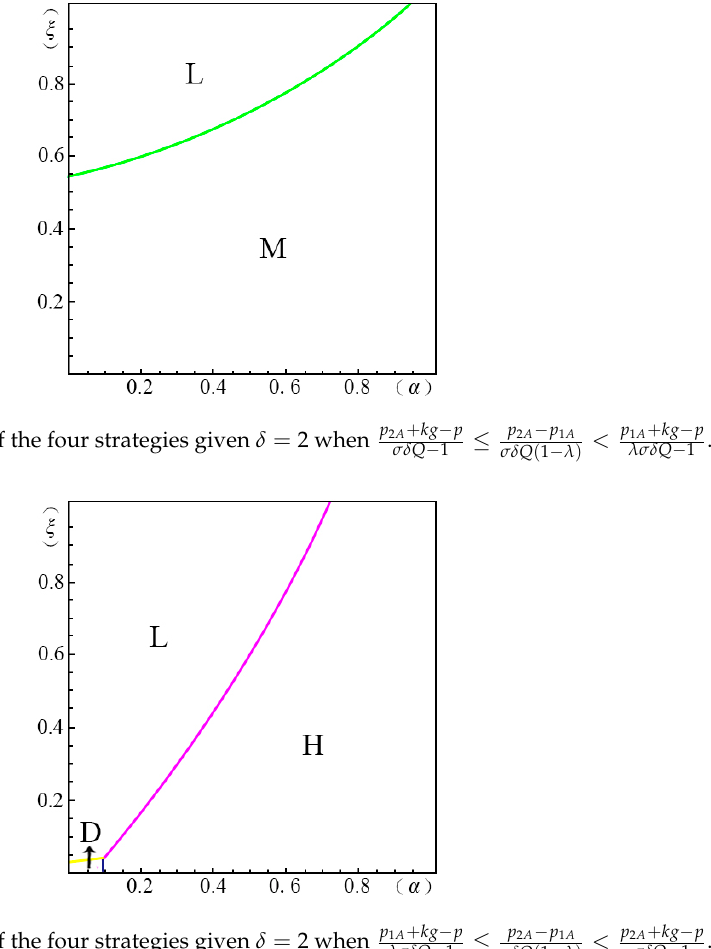
Figure 5. Comparison of the four strategies given (cid:2012) (cid:3404) 2 when (cid:3043) (cid:3117)(cid:3250)